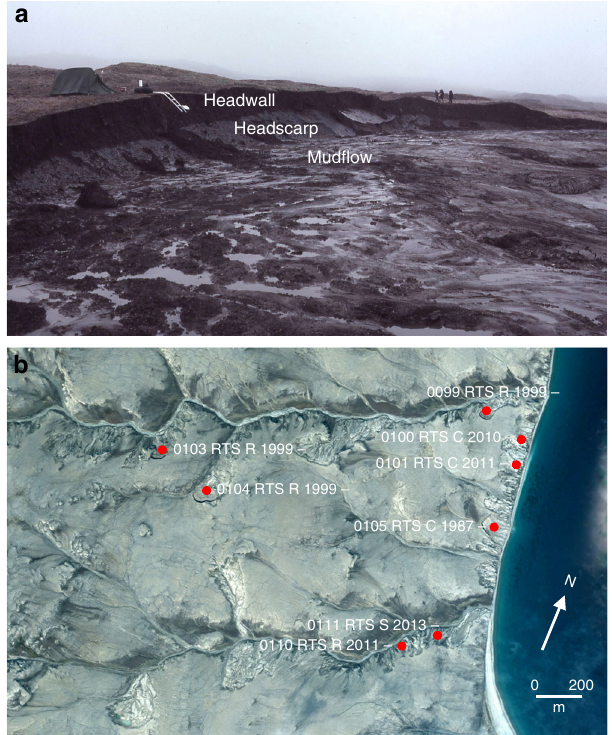
Fig. 1 Ground and satellite views of retrogressive thaw slumps. a Polycyclic coastal retrogressive thaw slumps in southwest Banks Island (71.717°N, 124.127°W). Headscarp is thawing ice-rich permafrost (averaging 85% ice by volume 18 ) while overlying headwall is the former stabilised mud fl ow comprising the active layer and ice-poor permafrost. Undercutting of the headwall by ablation of the ground ice results in soil collapse that temporarily covers the ice. b Quickbird image in Google Earth of part of the coast of eastern Banks Island (centred on 72.18°N 120.19°W) showing those retrogressive thaw slumps identi fi ed as active between 1984 and 2015 using the Timelapse dataset. Individual retrogressive thaw slumps are tagged with an identi fi cation number, the location of initiation (R-river, C- coast, L-lake or S-slope) and their years of activity. Where the start of thaw slumping post-dates the date of image acquisition (2004) the outline of the landform is not present. The absence of a fi nal date means that a retrogressive thaw slump was still active at the end of the Timelapse period. Note the many unnumbered retrogressive thaw slump scars where thermokarst activity was not observed during the Timelapse